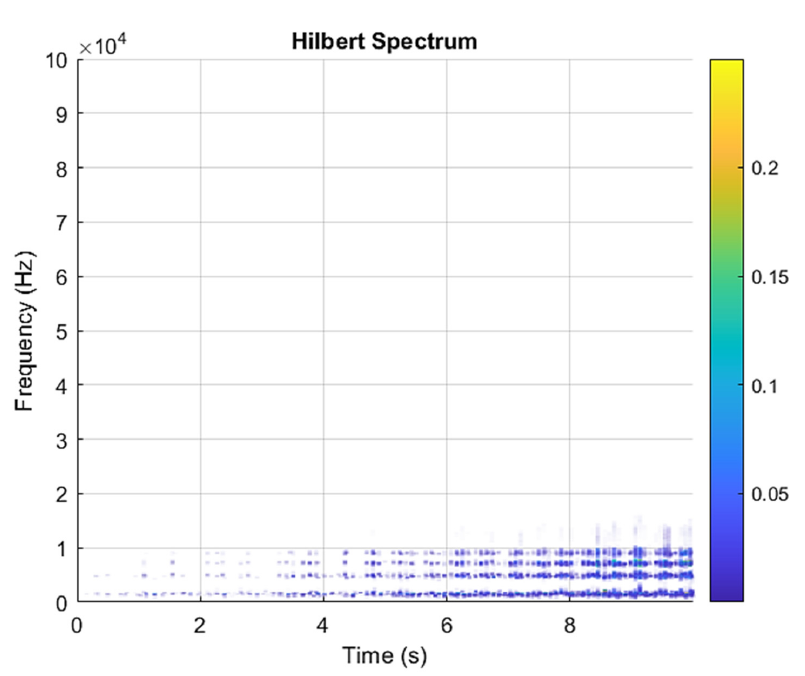
Figure 12. VMD analysis from a combined fault bearing under increasing rotational speed condition in Hilbert spectrum.